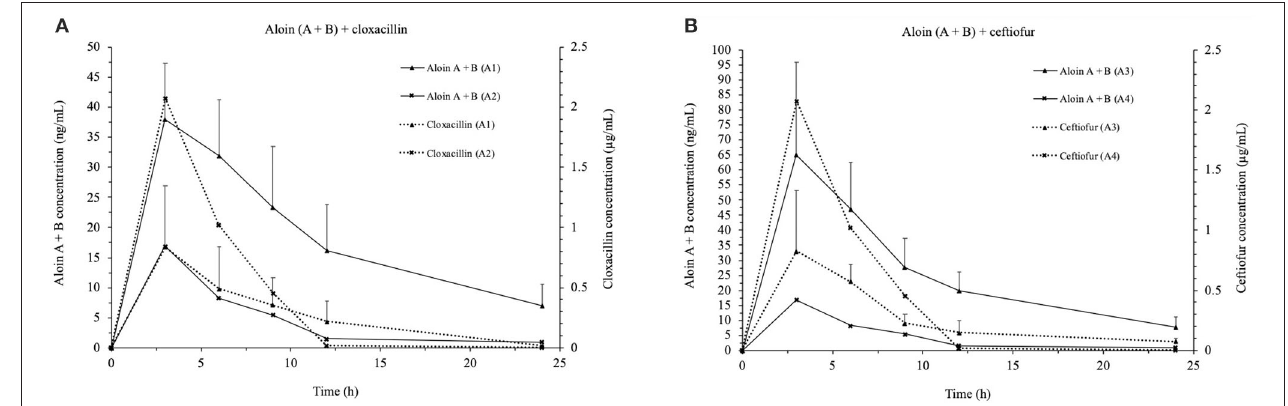
FIGURE 1 | Comparative concentrations (mean ± SD, n = 20 for groups in A1, A2, and A3 and n = 19 for group A4) of aloin A + B and cloxacillin or ceftiofur in milk after a single dose administration of: A1, 600 mg/ml of Aloe vera + 0.25 mg/ml of cloxacillin (A) ; A2, 600 mg/ml of Aloe vera + 0.5 mg/ml of cloxacillin (A) ; A3, 600 mg/ml of Aloe vera + 0.25 mg/ml of ceftiofur (B) , and A4, 600 mg/ml of Aloe vera + 0.5 mg/ml of ceftiofur (B) , respectively.